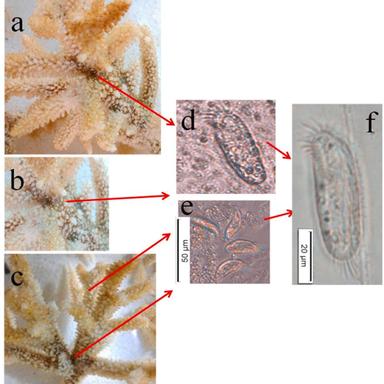
Acropora muricata disease lesions and the associated ciliate. a. tissue with initial white and later with brown discoloration surrounding dead tissue. b and c. the tissue with white syndrome due to stress and formation of white and brown discoloration. d, e and f. the ciliate isolated from the Acropora muricata disease lesions.